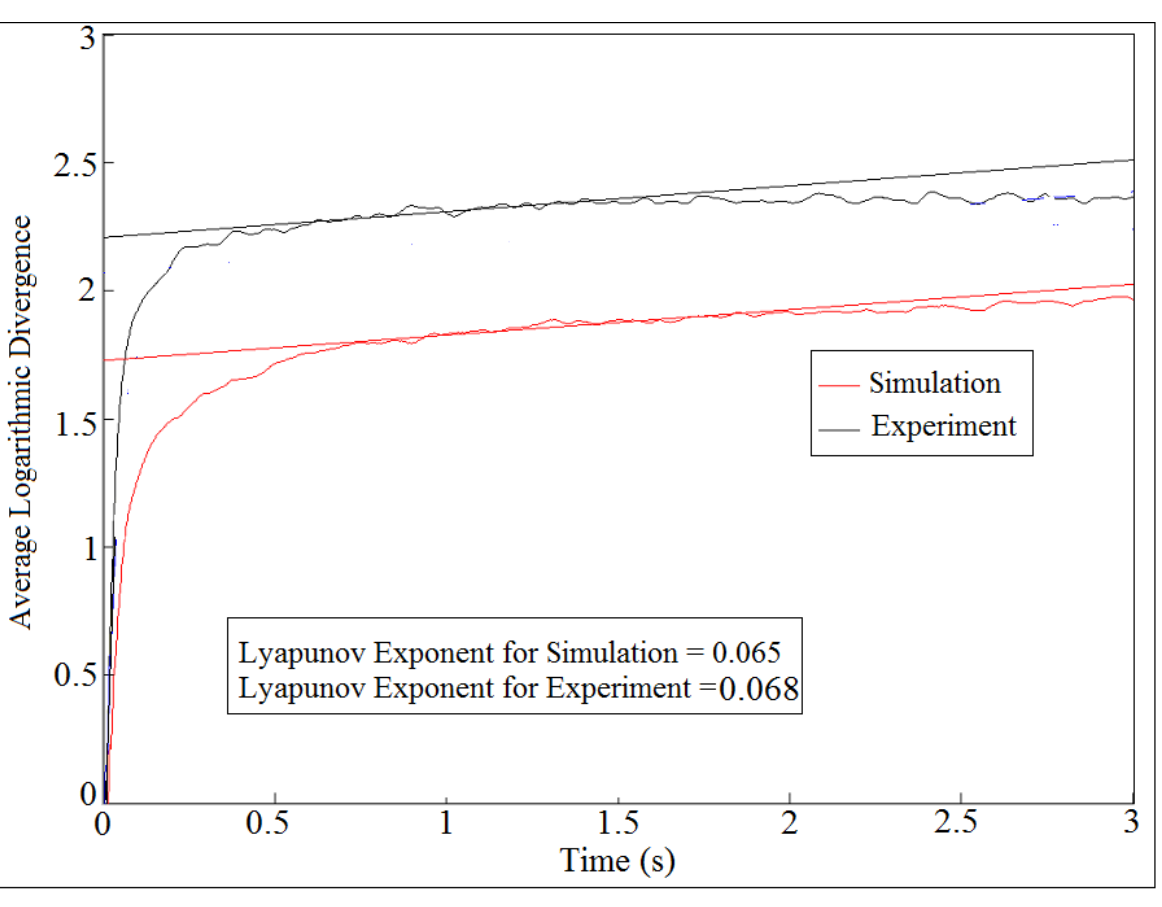
Figure 15. Average logarithmic divergence against time when the follower offsets to the right (O = 40 mm) at (N = 400 rpm).